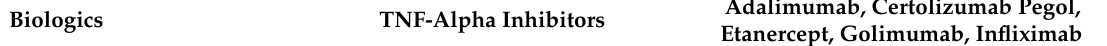
Table 1. Advanced targeted therapies (biologics and small molecules) and conventional immunosup- pressive medications, and other specific medications included in the